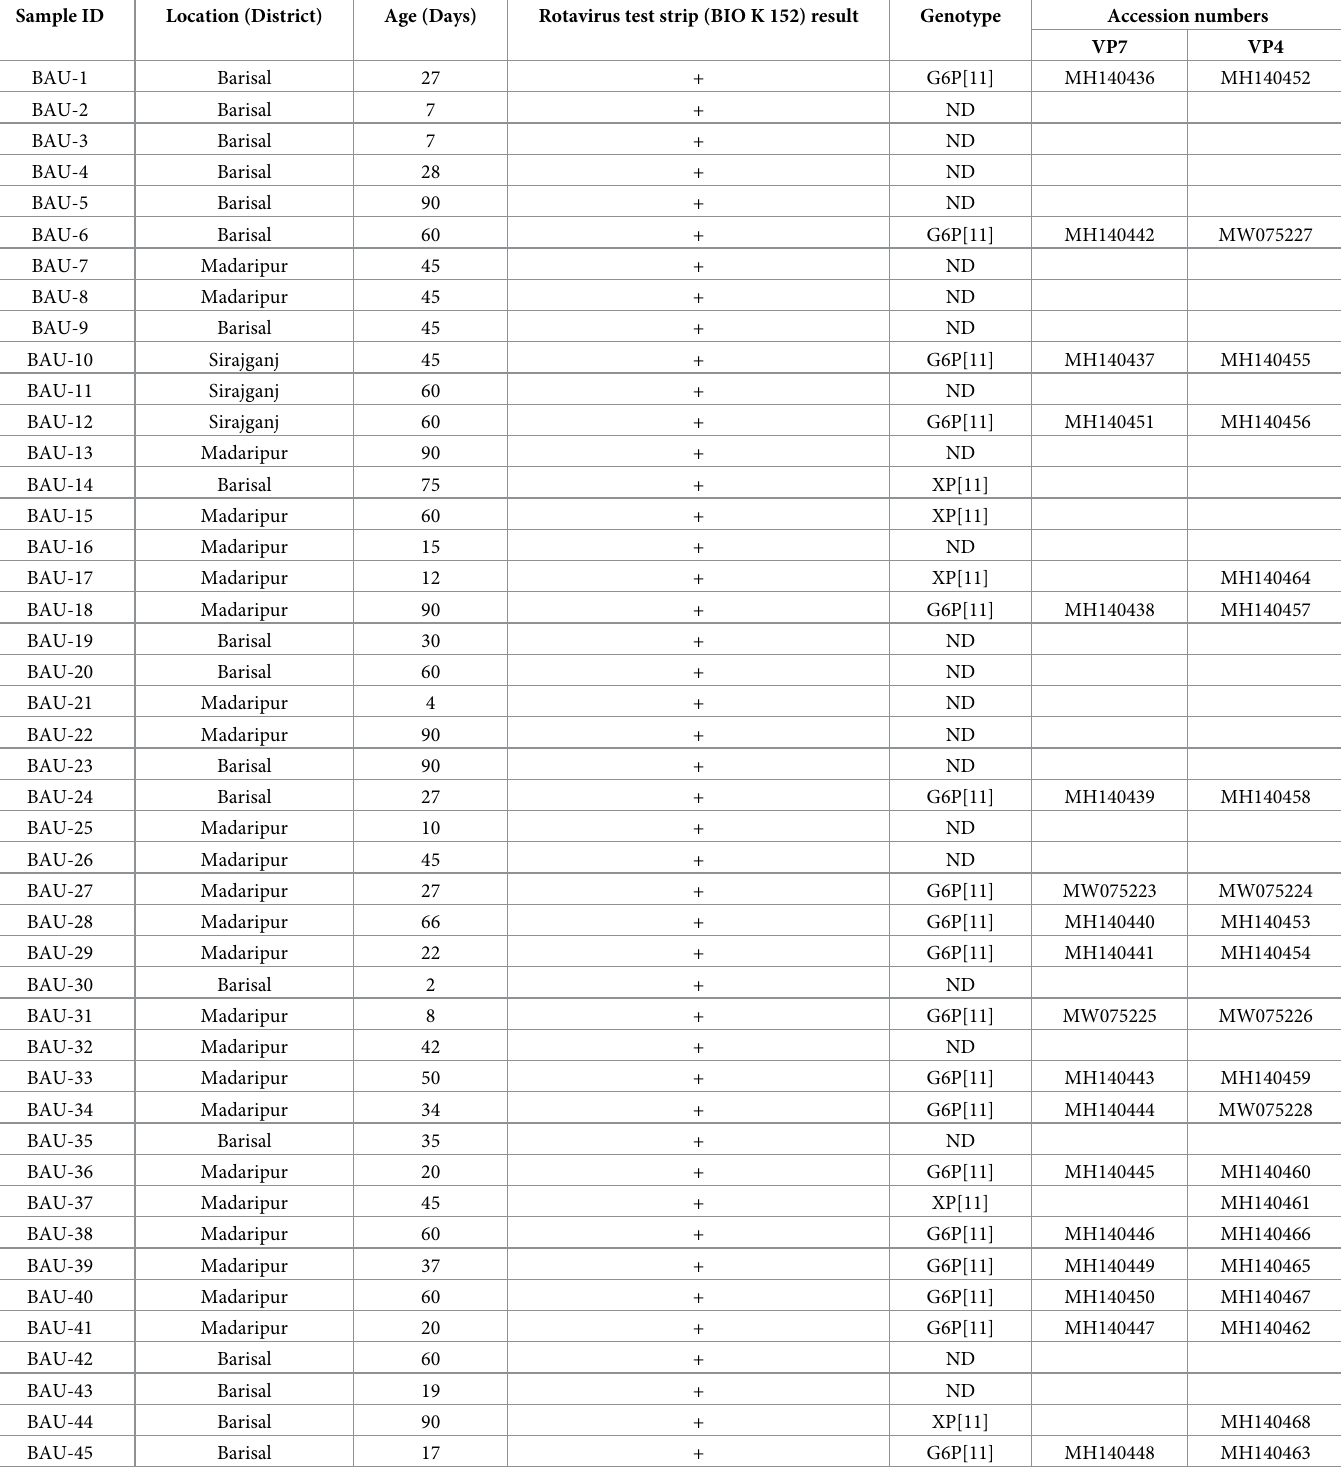
Table 2. Profiles of bovine rotavirus analyzed genetically and their gene sequences in a study of diarrheic calves in Bangladesh. Sample